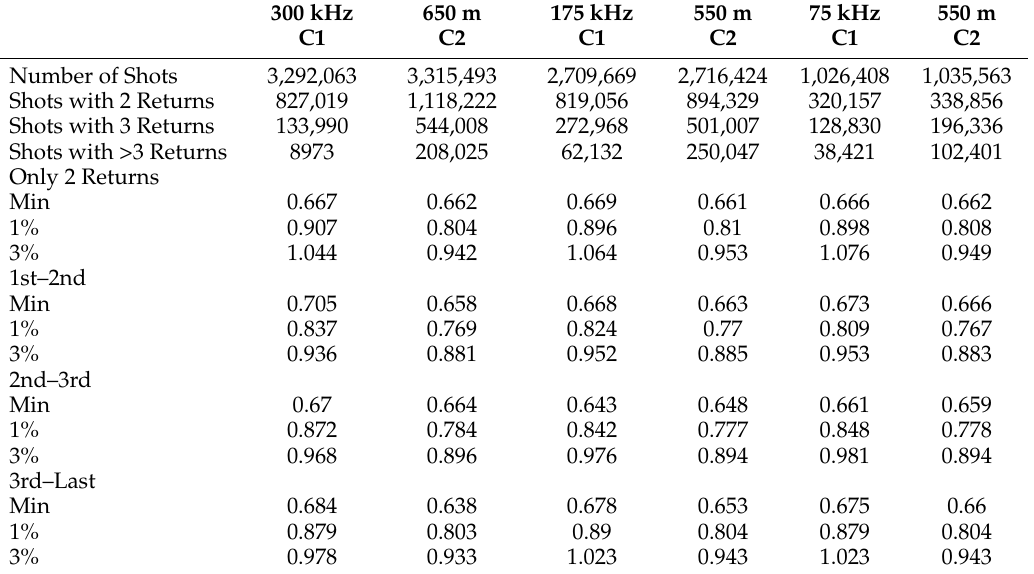
Table 8. Comparative results from minimum separation between returns test obtained from the Titan sensor running at different PRFs near the Lamani Mayan site in Belize. Range separation results are given in